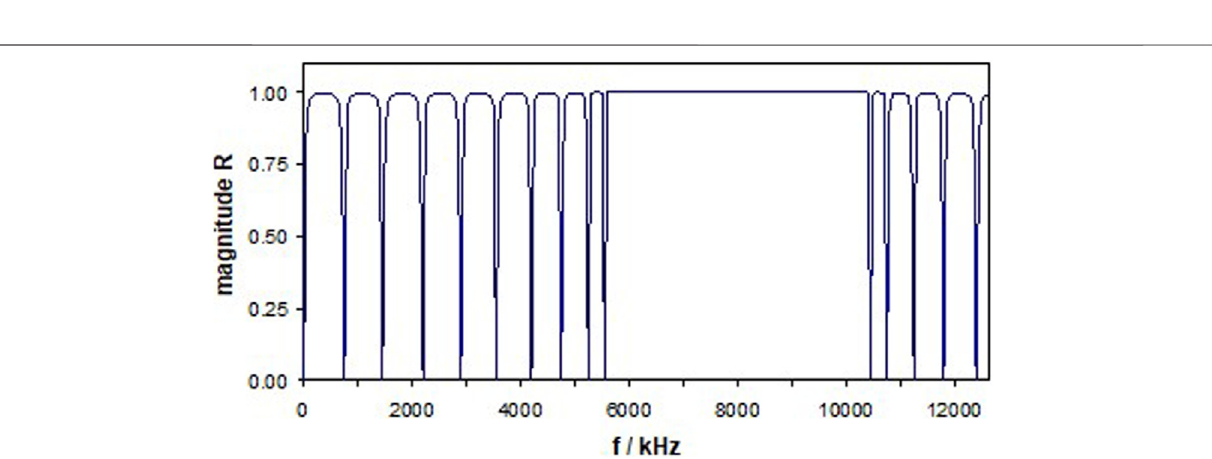
Frontiers in Mechanical Engineering |